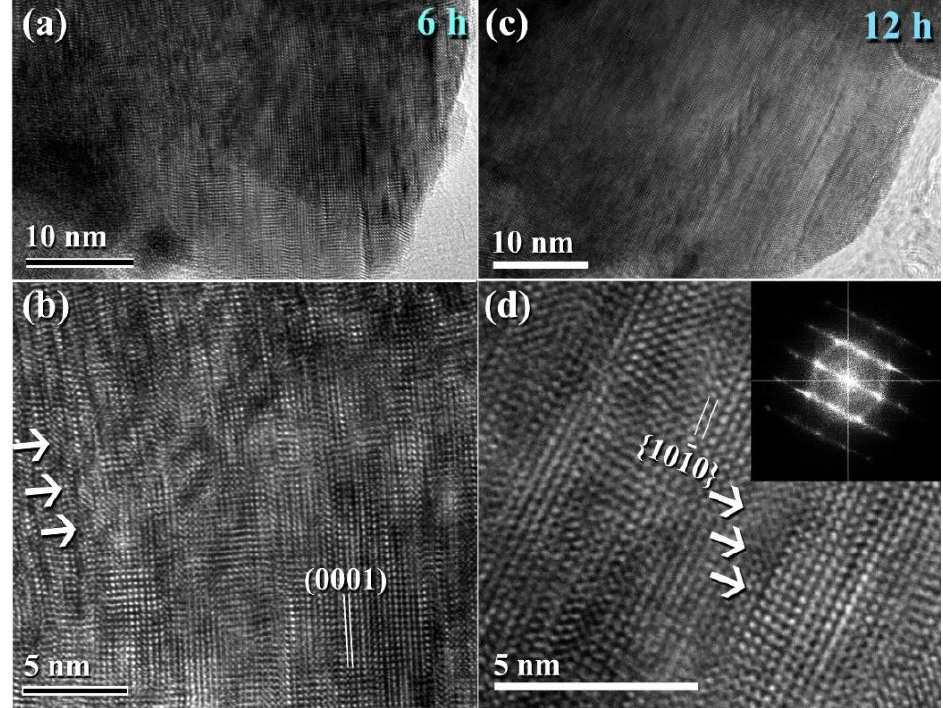
Figure 12. Lattice imperfections generated in WC crystals during the early stage of milling. HRTEM micrograph of ball milled WC powders after ( a , b ) 6 h, and ( c , d ) 12 h of milling. After 18–20 h of milling, the powders exhibited a nanospherical shape with an ap- parent diameter varying from 20 to 400 nm, as seen in Figure 13a,b. HRTEM micrograph of WC particles milled for 20 h (Figure 14c) As seen in Figure 14, the ultimate product generated after 20 h of MM had many gain boundaries with unpredictable crystallo- graphic orientations (a, b). We should stress that extending the MM duration to 20 h was required to achieve homogenous WC cells with a narrow grain size dispersion (5–9 nm), as shown in Figure 14c.